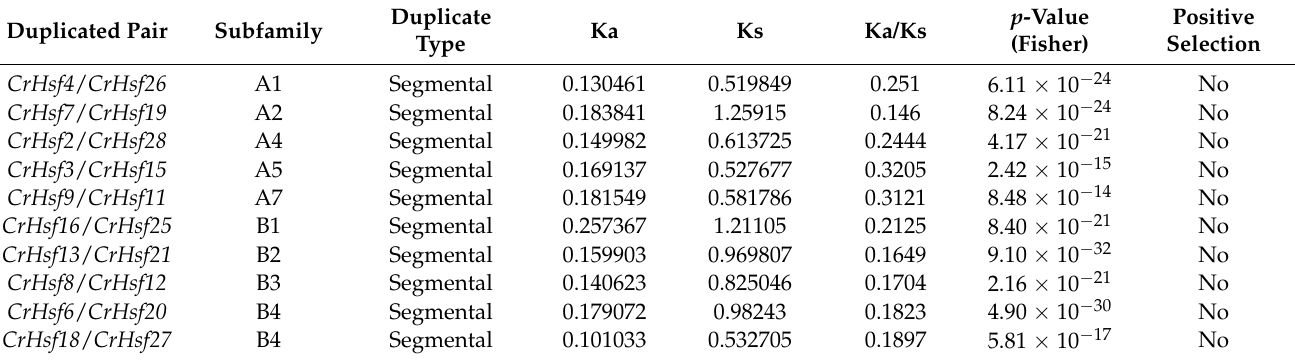
Table 3. Ka/Ks analysis (NG method) and duplicated data calculations for CrHsf